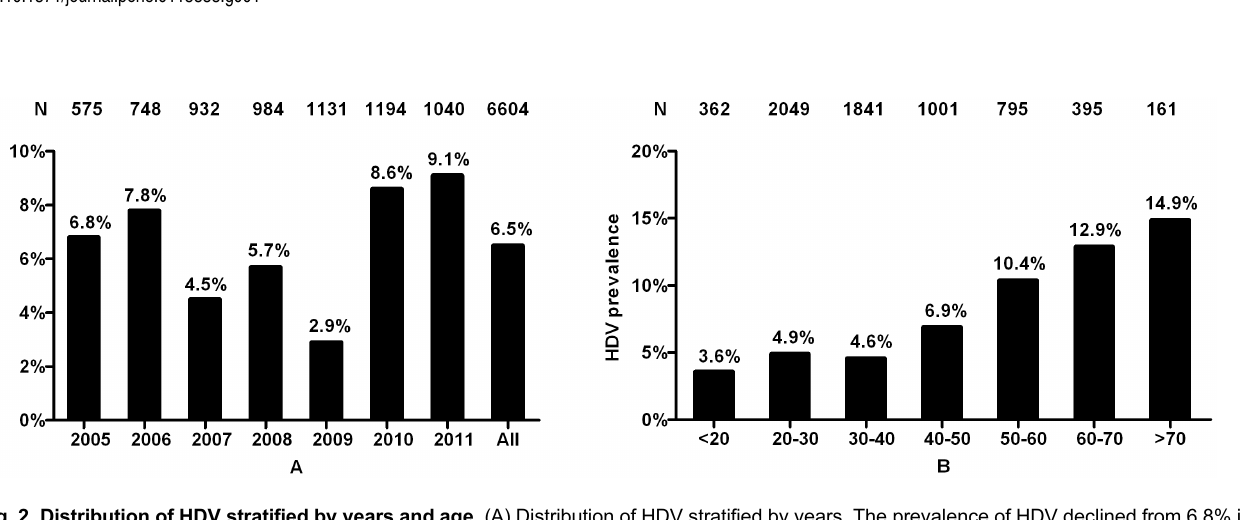
PLOS ONE | DOI:10.1371/journal.pone.0115888 December 22,